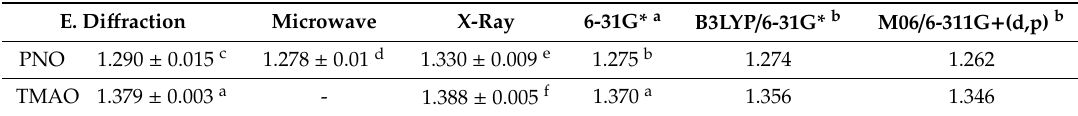
Table 4. Experimental and calculated N-O bond lengths (Angstroms) in pyridine N-oxide (PNO) and trimethylamine N-oxide